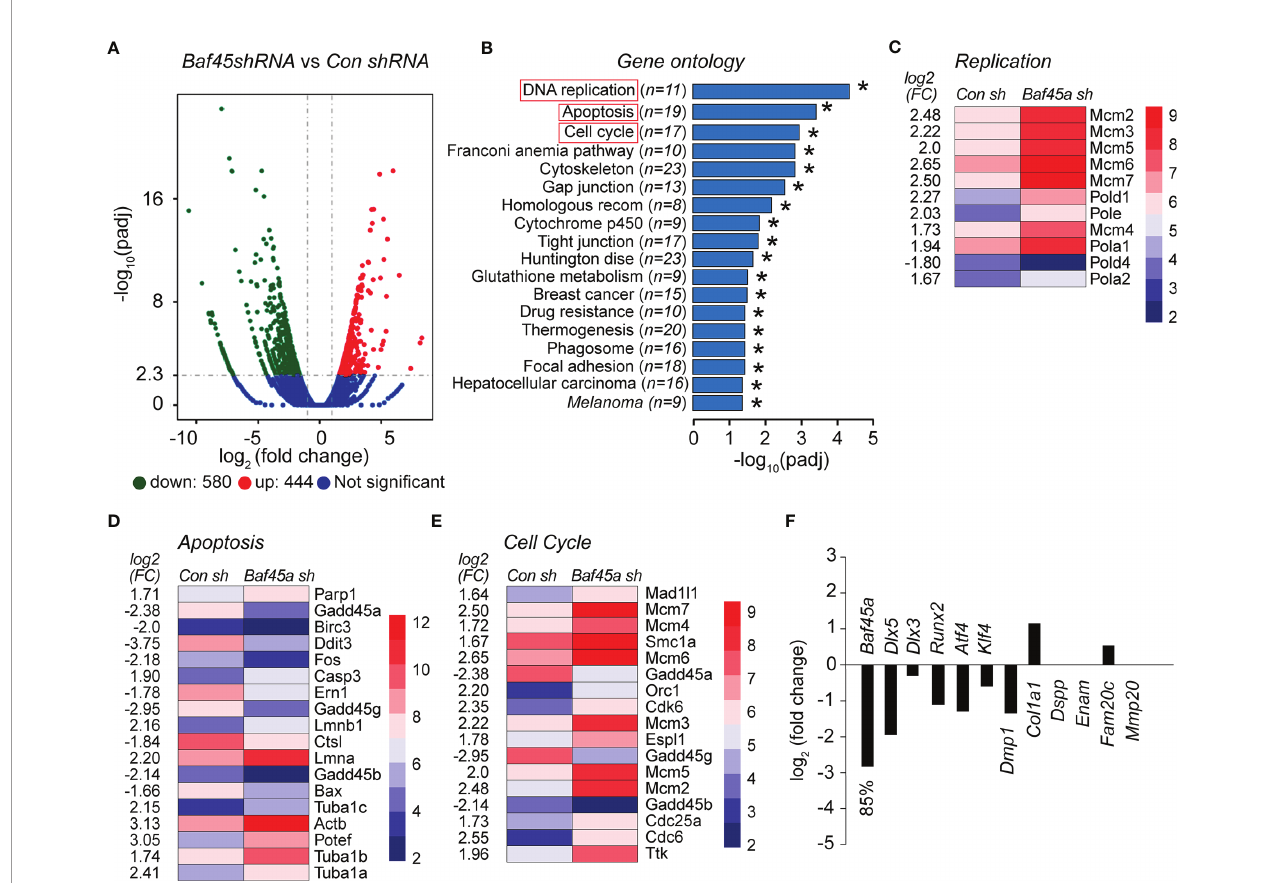
FIGURE 7 | The shRNA mediated knockdown of Baf45a in odontoblast OD-21 cells affect growth, DNA repair, and apoptosis. (A) Volcano plot comparison of differential gene expression between control shRNA (non-speci fi c) and Baf45a-speci fi c shRNA. Red dots highlight upregulated, and green dots highlight downregulated differentially expressed genes with threshold FDR < 0.01 and Log2 Fold Change [ ≥ 1]. The blue zone indicates the number of transcripts that do not show signi fi cant differential expression. (B) Functional annotation based on Gene Ontology (GO) categorization. The horizontal bar plot represents differentially enriched genes linked to biological processes (FDR < 0.05) identi fi ed in control shRNA vs. Baf45a speci fi c shRNA. *P < 0.05. (C – E) . Heatmap of differentially expressed genes belongs to DNA replication, apoptosis, and cell cycle. (F) The relative changes in the expression of osteoblast and odontoblast-speci fi c transcription factors and markers genes due to Baf45a